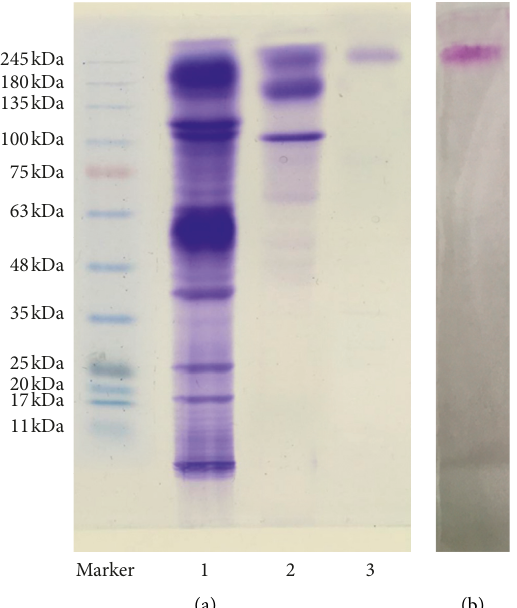
Figure 2: (a) Purity and molecular weight of LML by SDS-PAGE: lane markers: rainbow prestained markers (11kDa-245 kDa); lane 1: crude extract, 2.5 mg/mL, 20 μ L; lane 2: D-3 obtained by DEAE-52 ion-exchange chromatography, 1.4mg/mL, 20 μ L; lane 3: LML obtained by Sephadex G200 gel filtration chromatography, 1.0mg/mL, 20 μ L. (b) The electrophoretogram of LML by periodic acid-Schiff stain, 1.0 mg/ mL, 20 μ L.